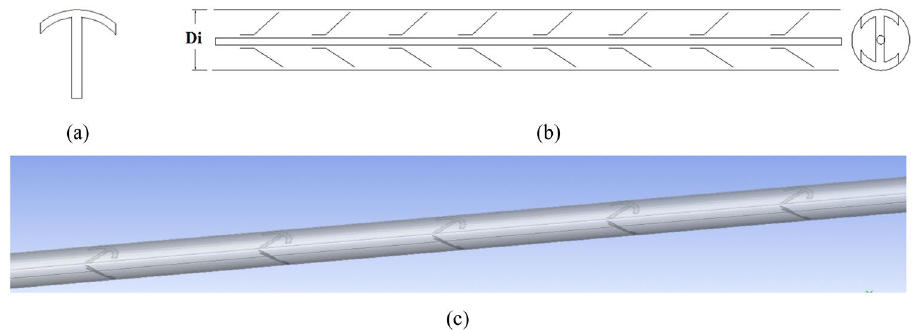
Fig. 3 a Modified insert b Pipe fitted with Modified insert c CAD model of MIs fitted test pipe